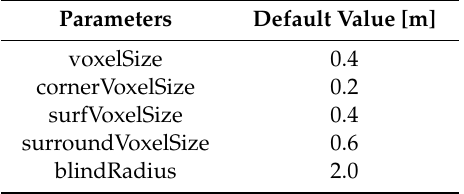
Table 3. Parameters setting of Kaarta Stencil 2, optimized for outdoor scenario.